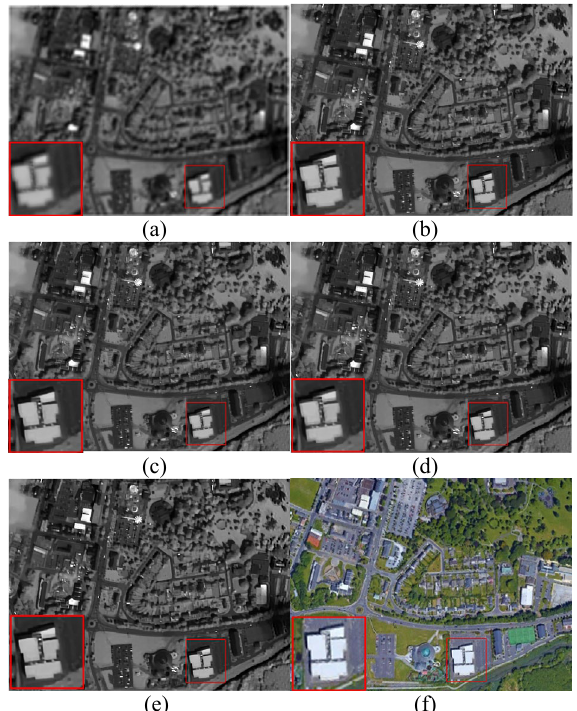
Figure 8. Blurred image reconstruction for GF-2 satellite. (a) input image. The reconstruction results of: (b) DCP, (c) ECP, (d) PMinP, (e) CPMMP. (f) an RGB image from Google Earth. The comparison with the house edges are zoomed in red rectangle.